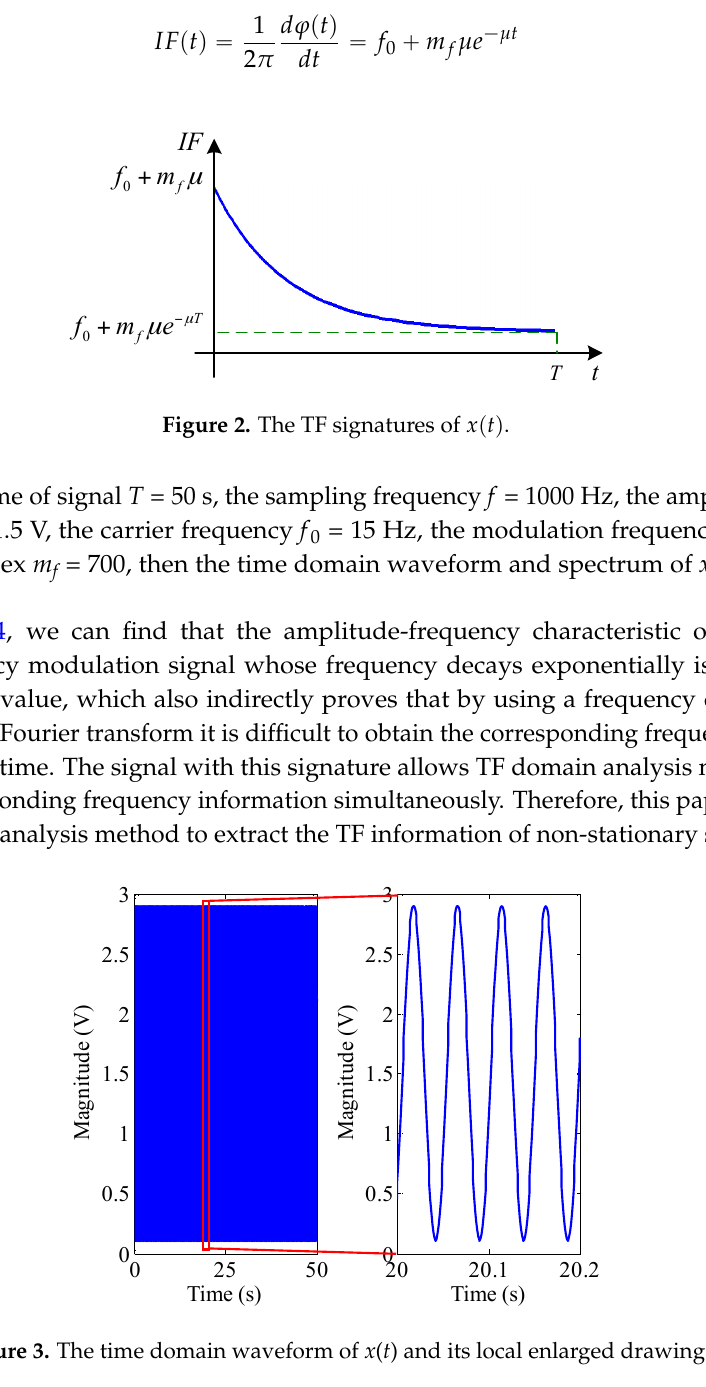
Figure 4. The Fourier spectrum of x ( t ) . 3.2. BCZT TF Domain Analysis Method The STFT is a superposed window function on the basis of Fourier transform to track the local feature changes of signals with the assumption that the signal in each window is stationary, yet, the nature of STFT is based on a Fourier transform, and the Fourier transform itself has low resolution, therefore the STFT accuracy is lower. Motivated by the act that STFT is the Fourier transform of the superposed window function, this paper presents a BCZT TF domain analysis method (see Figure 5). samplesignal sliding window N M j j+M- 1 Figure 5. The BCZT TF domain analysis method.